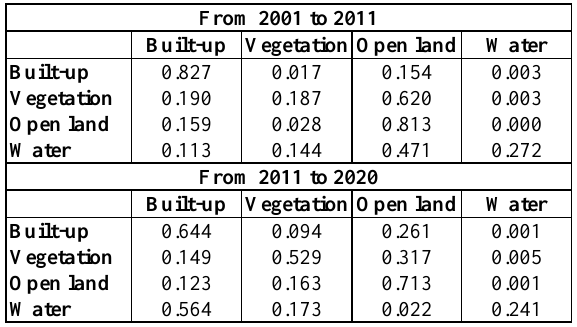
Table 5. Transition matrix of Bengaluru for the years